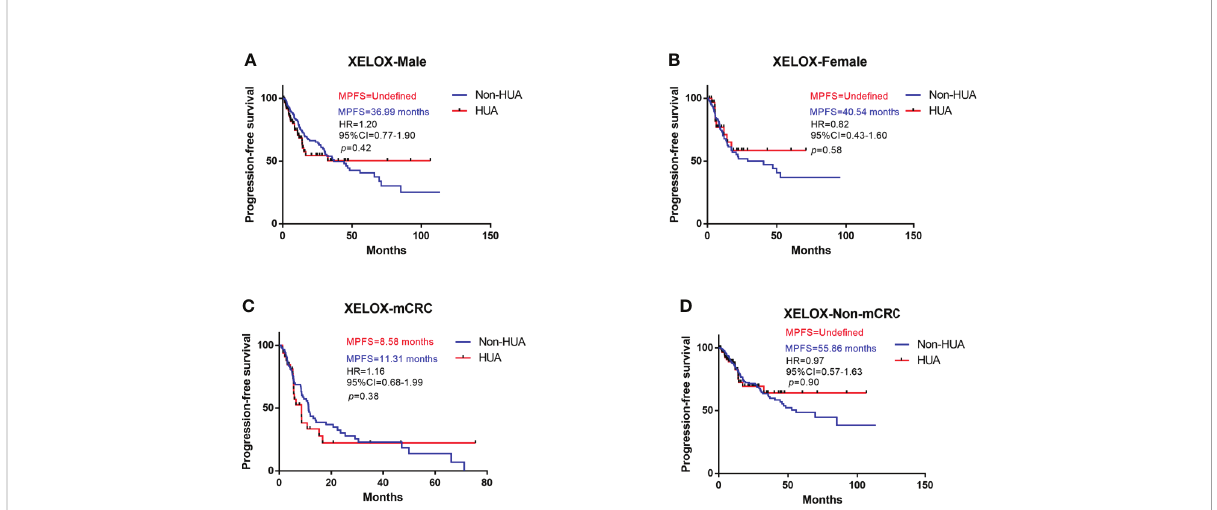
FIGURE 6 Subgroup analysis for PFS of patients treated with XELOX. HUA, high uric acid, Non-HUA, non-high uric acid, MPFS, median PFS. (A) PFS of male CRC patients treated with XELOX. (B) PFS of female CRC patients treated with XELOX. (C) PFS of the mCRC patients treated with XELOX. (D) PFS of the non-mCRC patients treated with XELOX.